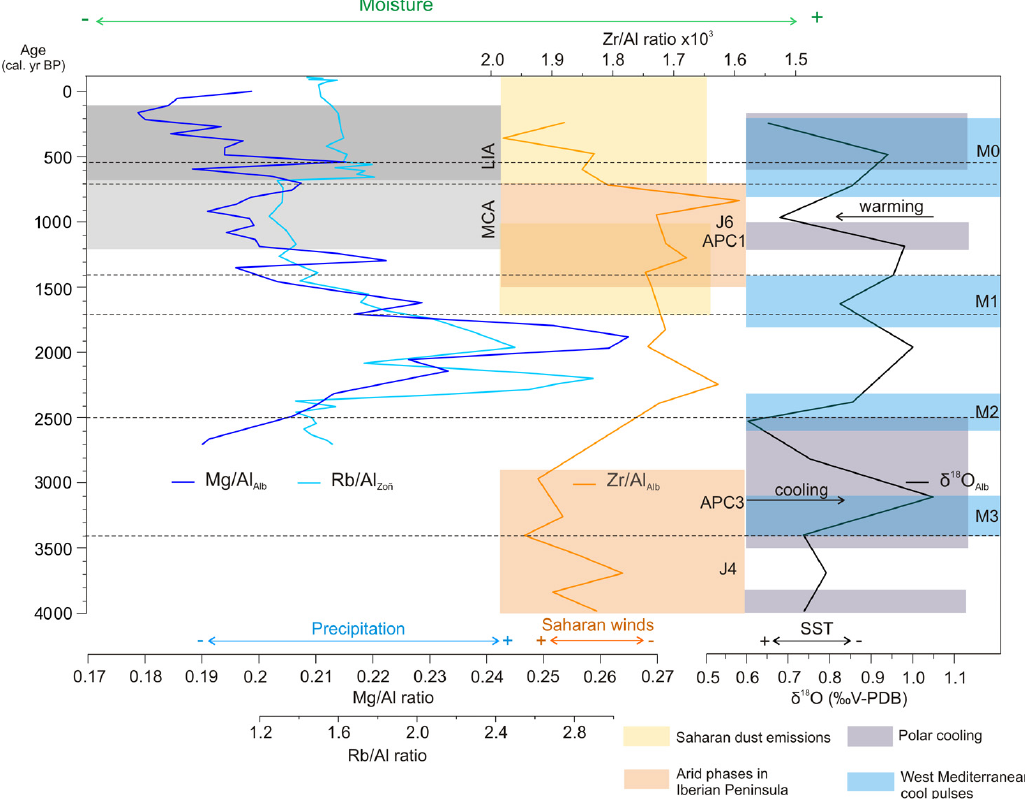
Fig. 4. Marine and continental geochemical proxies for climate variability: Rb/Al ratio from Zo˜nar Lake sediments and Mg/Al ratio from the Alboran Sea sediments reflect precipitation; Zr/Al ratio indicates Saharan winds; δ 18 O is a proxy for Sea Surface Temperature (SST). Climatic events defined for the western Mediterranean region during the Late Holocene are included for comparison: Alboran Sea pollen events from core ODP 976 (APC1 and APC3) (Combourieu-Nebout et al., 2009), aridification phases in the western Mediterranean (J4 and J6) (Jalut et al., 2000), polar cooling (Mawyesky et al., 2004) and central Mediterranean cold pulses (M0 to 3) (Frigola et al.,